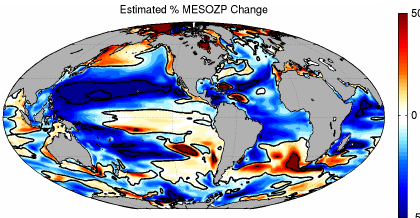
Figure 5. Change in the maximum monthly mixed layer depth (MLD, m): (2051–2100)–(1951–2000). The 0 contour is shown.